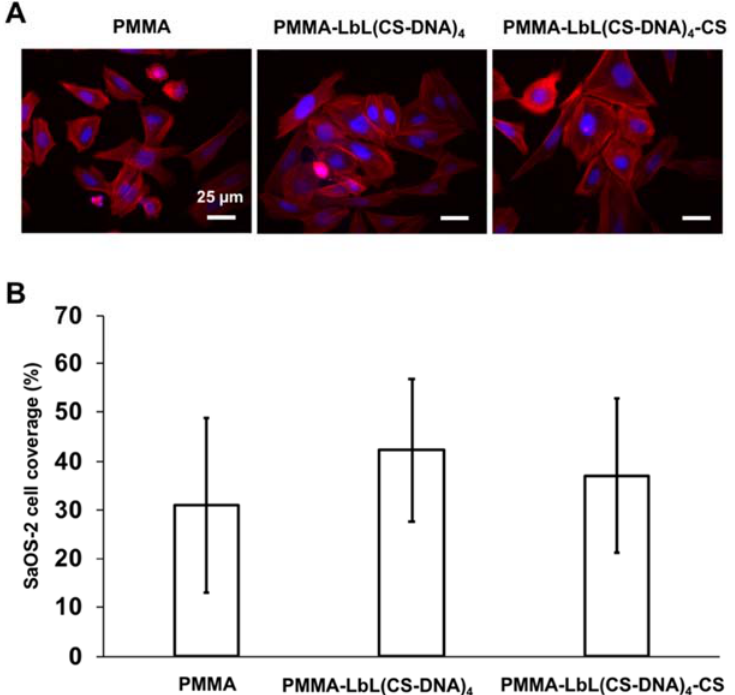
Figure 8. ( A ) Fluorescence microscopic images of SaOS-2 cells after 48 h growth on PMMA, PMMA-LbL(CS-DNA) 4, and PMMA-LbL(CS-DNA) 4 -CS surfaces. SaOS-2 cells were stained with PBS containing DAPI and TRITC-phalloidin. The scale bar denotes 25 µm. ( B ) Surface coverage by SaOS-2 cells after 48 h of growth on uncoated and multilayer-coated PMMA surfaces. The error bars represent the standard deviation over three replicate samples and six images per sample with separately cultured SaOS-2 cells. ANOVA tests were performed, and no significant differences were observed between surfaces.